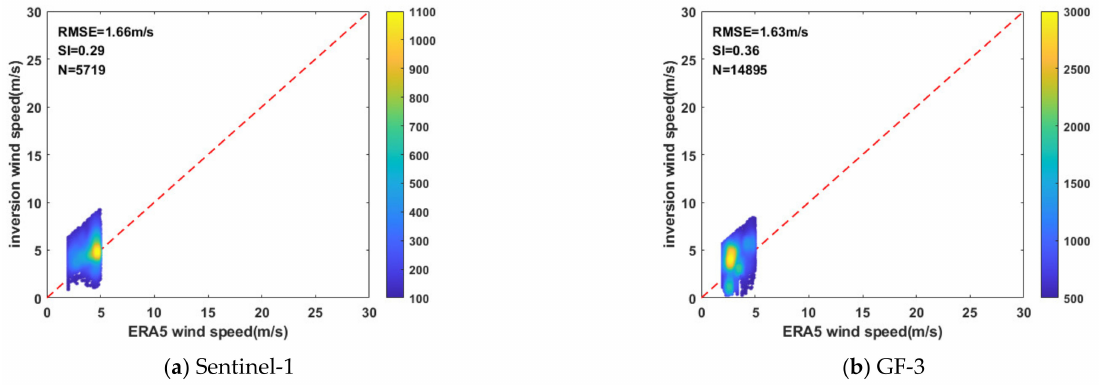
Figure 5. SAR data inversion results of Sentinel-1 and GF-3 when the wind speed is 0~5 m/s.